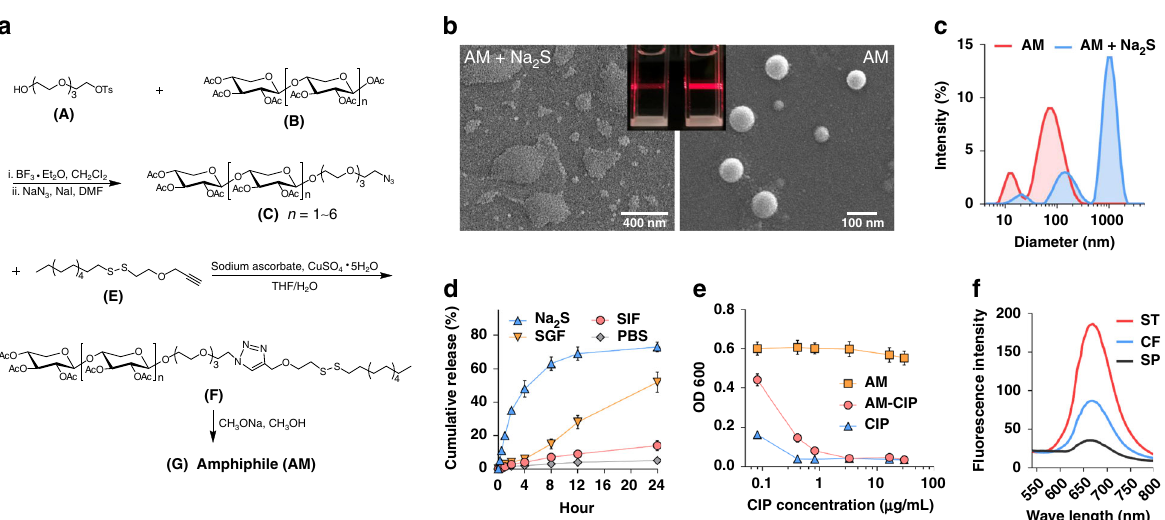
Fig. 1 Synthesis and characterization of AM vesicles. a Synthetic route of amphiphile (AM). b Scanning electron microscopic (SEM) images of AM vesicles with (left) or without (right) Na 2 S (100 μ M). Scale bars represent 400 nm (left) and 100 nm (right), respectively. Inset: Tyndall effect of AM vesicles with or without Na 2 S. c Hydrodynamic size distribution from DLS analysis in the absence or presence of Na 2 S (100 μ M). d Cumulative release pro fi les of AM- CIP in PBS, PBS with Na 2 S (100 μ M), simulated gastric fl uid (SGF), or simulated intestinal fl uid (SIF). Each is performed in triplicate. e In vitro bactericidal activity of free CIP (CIP), CIP-loaded AM vesicles (AM-CIP), and blank AM vesicles against S. typhimurium bacteria. Each is performed in triplicate. f Fluorescence intensity of Fluo-loaded AM vesicles (containing 10 μ M Fluo) incubated with S. typhimurium (ST), C. freudii (CF), or S. paratyphi A (SP) (10 6 CFU mL − 1 ) for 12 h. Data are means ± SD, representative of three technical repeats. Source data are provided as a Source Data fi